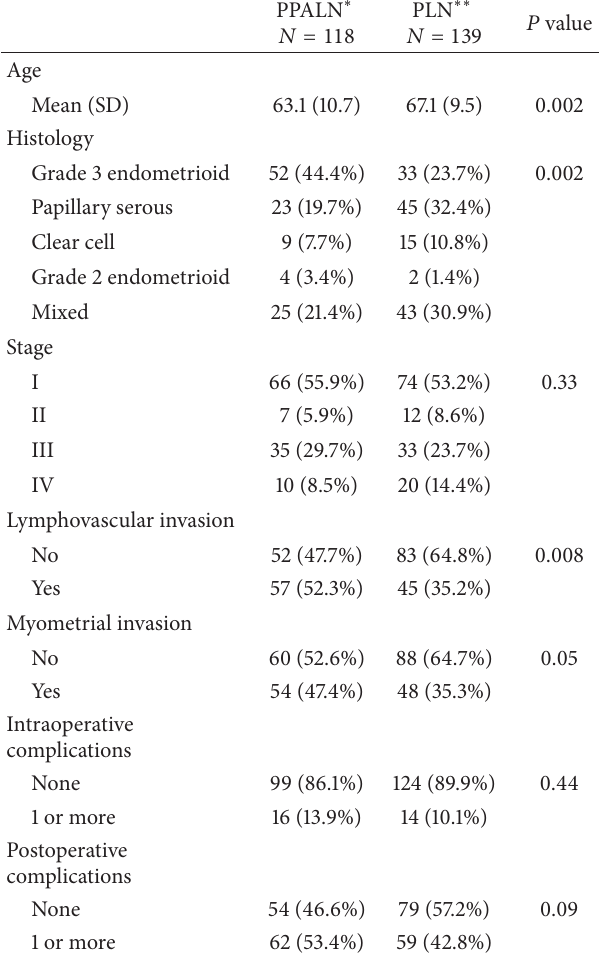
Table 1: Demographic and clinical characteristics of patients in the PPALN and the PLN